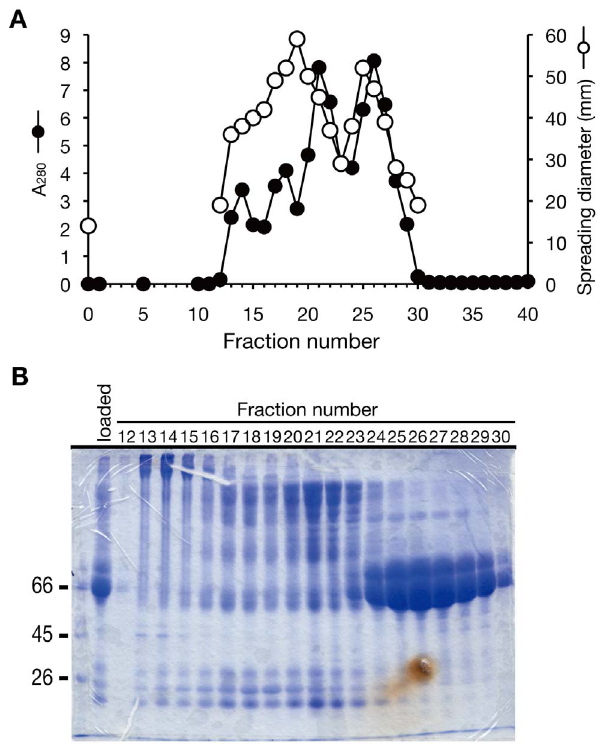
Figure 3. Gel filtration column chromatography of calf serum. (A) Elution profile of gel filtration column chromatography using a Superdex 200. Open circles indicate diameters of colonies. Filled circles indicate absorbance at 280 nm. Molecular weight markers were eluted in the fraction described below. Catalase (250-kDa) was eluted in fraction 21, bovine serum albumin (66-kDa) in fractions 25–26, and cyanocobalamin (1.3-kDa) in fraction 38. 250- m l aliquots of each sample were applied to soft agar medium and their colony-spreading stimulatory activity was measured. (B) SDS-PAGE analysis of gel filtration fractions. The gel was stained with Coomassie Brilliant Blue. A 66-kDa protein coincided with the colony-spreading stimulatory activity in fractions